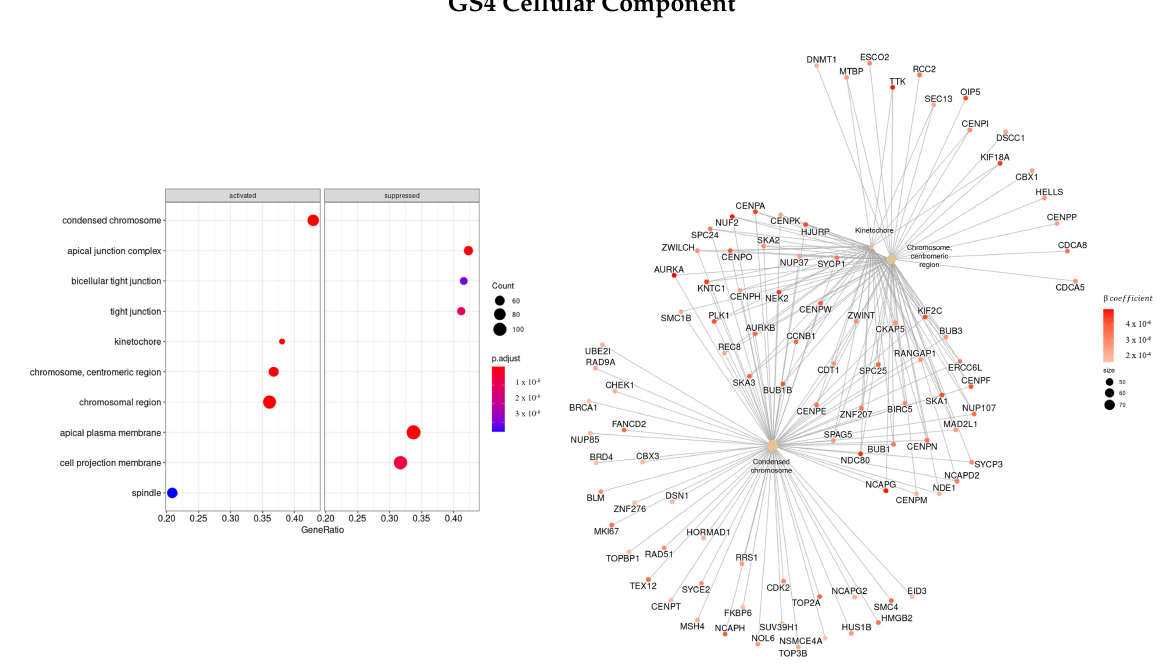
Figure 12. Gene ontology enrichment analysis regarding cellular components terms for a list of genes selected by TCox ranked by the β coefficients of the regression. The left panel shows a dot chart with the most significant CC terms. The right panel shows a gene-concept network plot of the three most enriched terms that depicts the linkages of genes and biological concepts as a